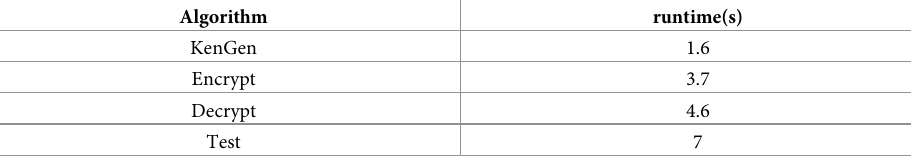
Table 10. Computational efficiency of 2048bit.